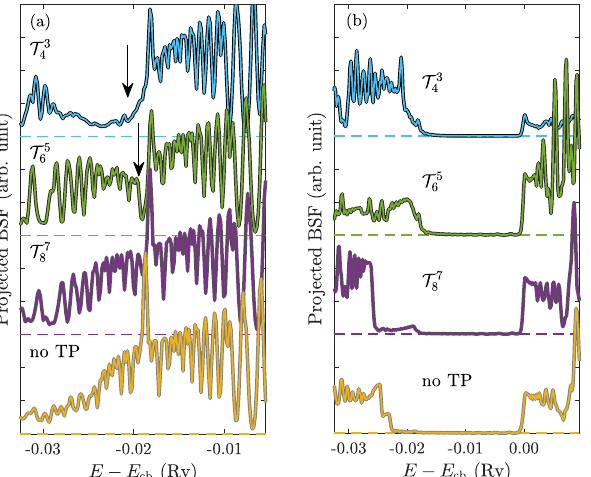
Figure 12. Projected BSFs of pure Bi 2 Se 3 in the vicinity of Γ point as a function of the position of TP. Spin up and spin down channels are overlaped. Obtained surface gaps are denoted by arrows. ( a ) PBSF of the surface QL , ( b ) PBSF of the fifth QL from the surface. Energy axes are scaled to the position of conduction band edge E cb at the fifth